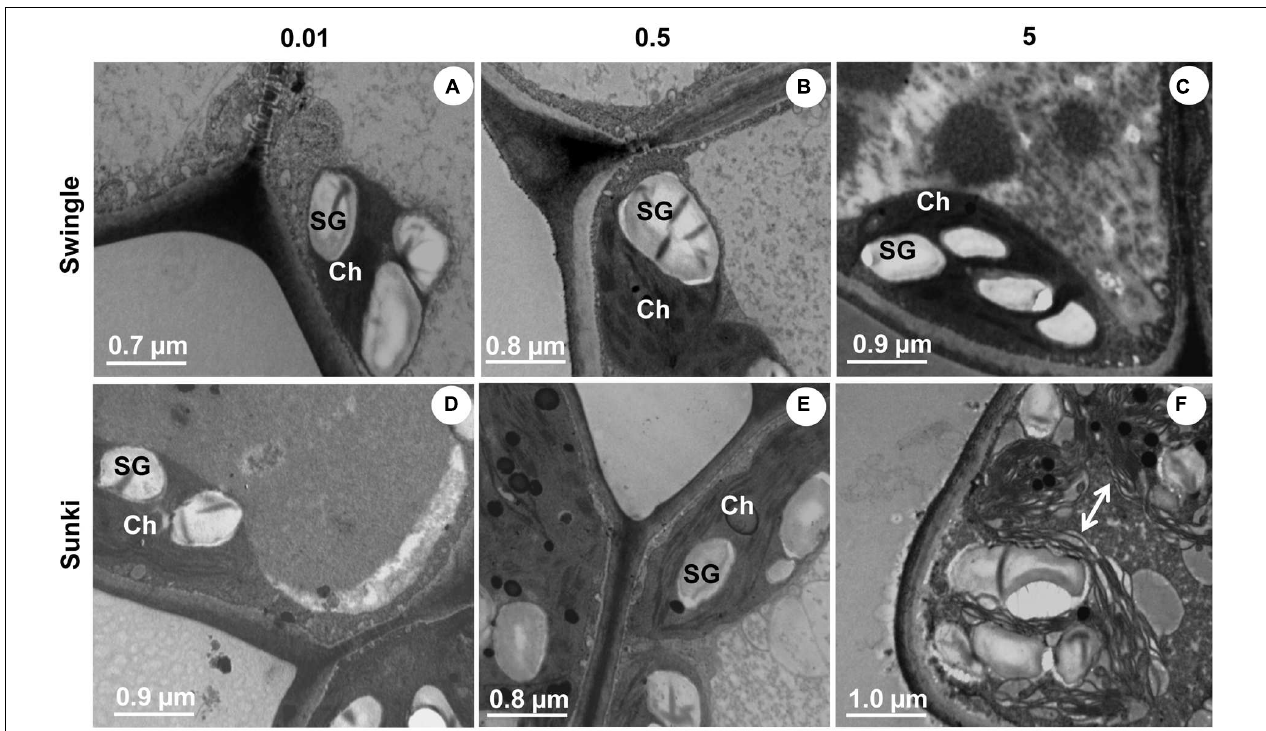
FIGURE 8 | Transmission electron microscopy of leaves of sweet orange trees grafted on Swingle (A–C) or Sunki (D–F) rootstocks grown in nutrient solution with varying concentrations of B for 130 days. Concentration of nutrient solution, in mg L − 1 of boron: left (0.01), center (0.5), and right (5.0) columns. Legend: SG, starch grains; Ch, chloroplast; arrow, unstructured